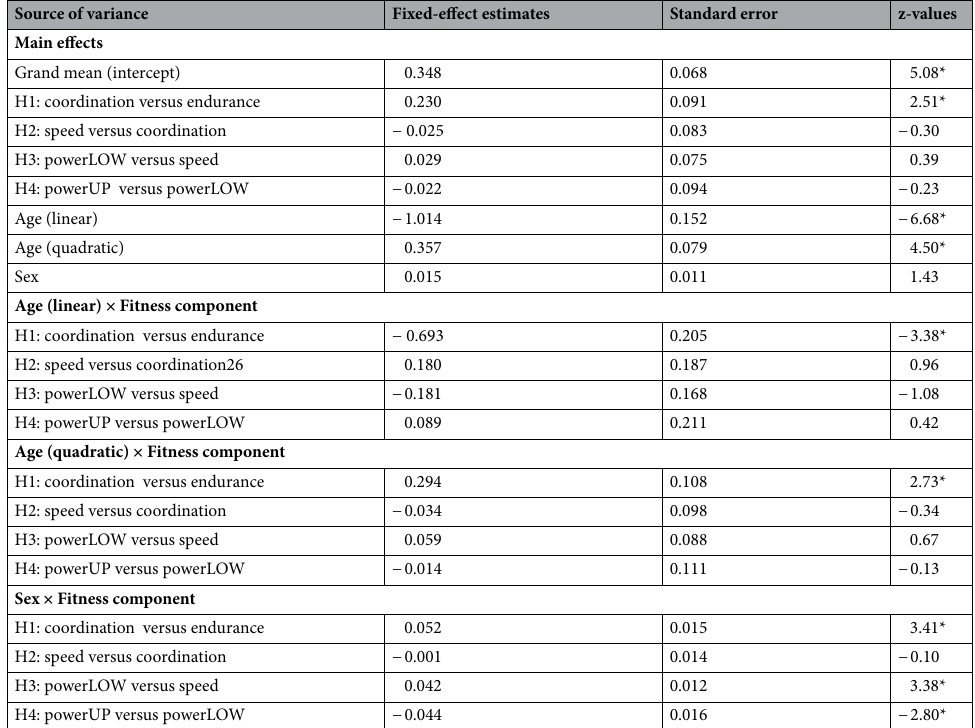
Table 2. Fixed-effect estimates of linear mixed model for older-than-keyage (OTK) children. H1– H4 = hypothesis 1–4, endurance = cardiorespiratory endurance (i.e., 6 min run test), coordination = star